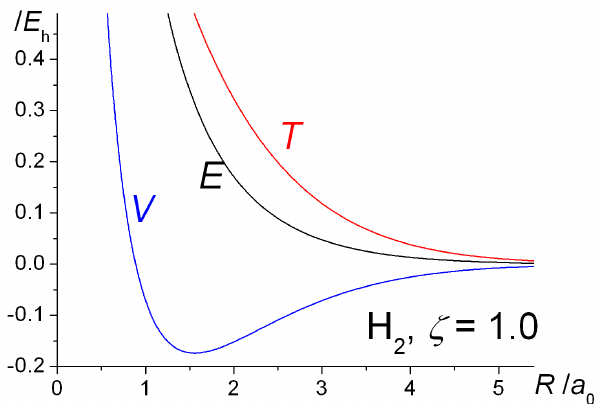
Figure 15. The bond energy of the VB-like ground state formed from Löwdin orthogonalized AOs, as given by Equation 46.